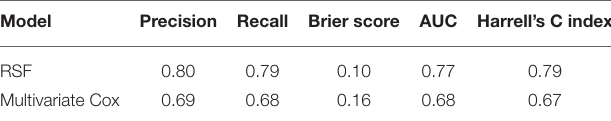
TABLE 4 | Performance comparisons of RSF and multivariate Cox models to predict VT/VF post diagnosis with 2-fold cross validation approach.